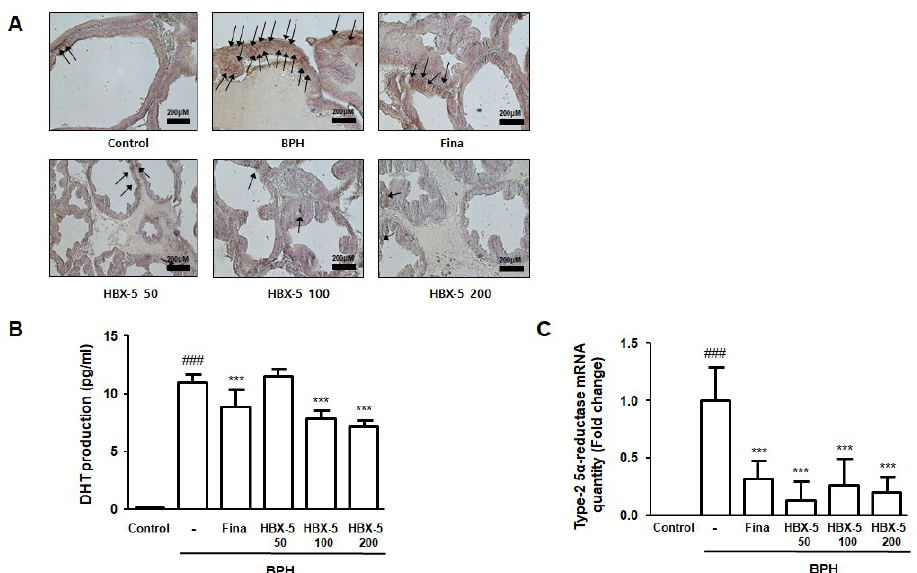
Figure 5. Effect of HBX-5 administration on the expression of AR and level of 5 α -reductase 2 mRNA and production of DHT in rats with BPH. ( A ) The manifestation of AR in prostate tissues was performed by IHC. The arrows indicate immunoreactivity of AR in the representative pictures of each group. ( B ) Serum concentration of DHT was determined by ELISA. ( C ) Expression of 5α-reductase 2 mRNA in prostate tissues was analyzed by quantitative real-time PCR. Values are the mean ± SD ( n = 10); ### p < 0.001 vs. Control group; *** p < 0.001 vs. BPH group. significances between treated groups were determined using ANOVA and Dunnett’s post hoc test. Control, Control group; BPH, rats with BPH group; Fina, rats with BPH group treated with 5 mg/kg/day of finasteride; HBX-5 50, rats with BPH group treated with 50 mg/kg/day of HBX-5; HBX-5 100, rats with BPH group treated with 100 mg/kg/day of HBX-5; HBX-5 200, rats with BPH group treated with 200 mg/kg/day of HBX-5.